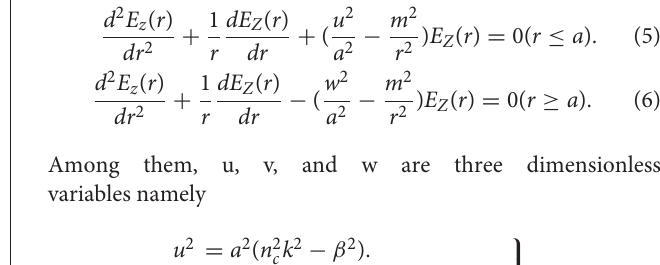
FIGURE 2 | Refractive index of Bragg fiber with high-index core.